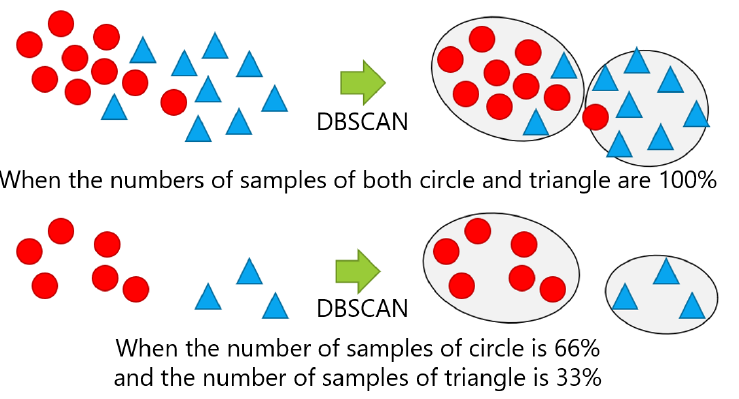
Figure 13. Example of changing the breakdown of positions: The top and bottom are the cases with 100% of both the circle and triangle classes and with 66% of the circle and 33% of the triangle classes,